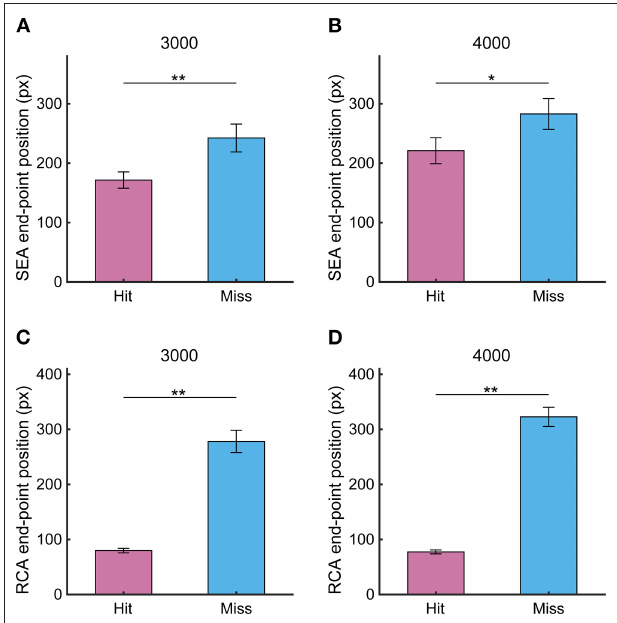
FIGURE 5 | The end-point position of (A,B) SEA and (C,D) RCA at target speeds of 3,000 and 4,000 pixels/s in Experiment 1. Pink and light blue bars show Hit and Miss, respectively. Error bars are SEM. * p < 0.05, ** p < 0.01.